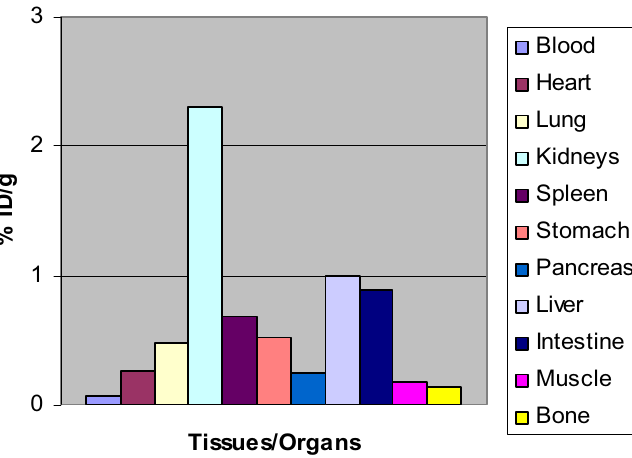
FIGURE 5 – Uptake of 99m Tc-HYNIC-RGD analog in tissues/organs.